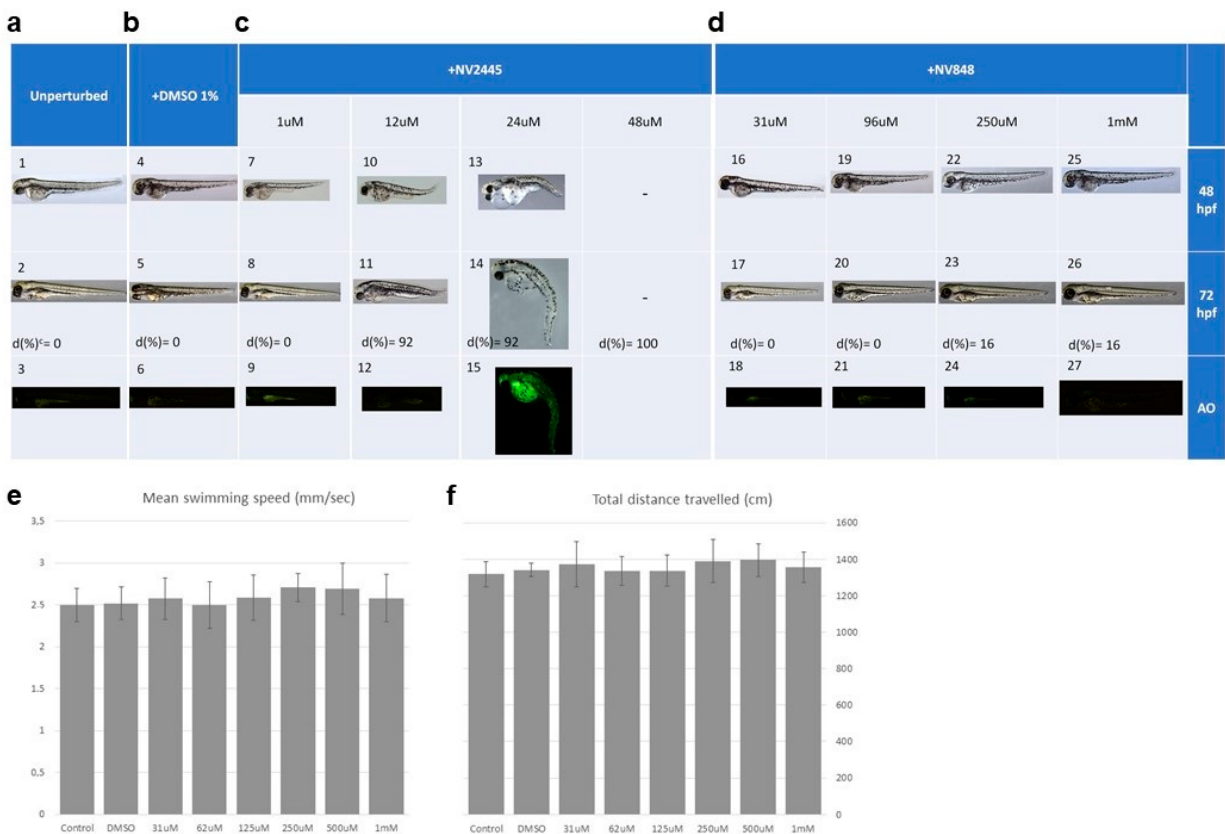
Figure 6. Evaluation of the toxic effects in zebrafish embryos. Toxicity assay and apoptosis assay after exposure to the indicated molecules ( a ): unperturbed control; ( b ): DMSO control; ( c ): NV2445; ( d ): NV848 at the indicated developmental stages. The locomotor behavior of zebrafish embryos after treatment with NV848-Control NV848-treated larvae was assessed at 5 dpf. A 96-well plate containing larvae was transferred into the Zebralab platform and larvae allowed to acclimate for 15 min with the illumination of the testing chamber set at 50 1 × . ( e ), Zebrafish swimming velocity upon NV848 treatment compared to control. ( f ), Total distance travelled by zebrafish upon NV848 treatment compared to control. AO, acridine orange staining; d(%), mortality